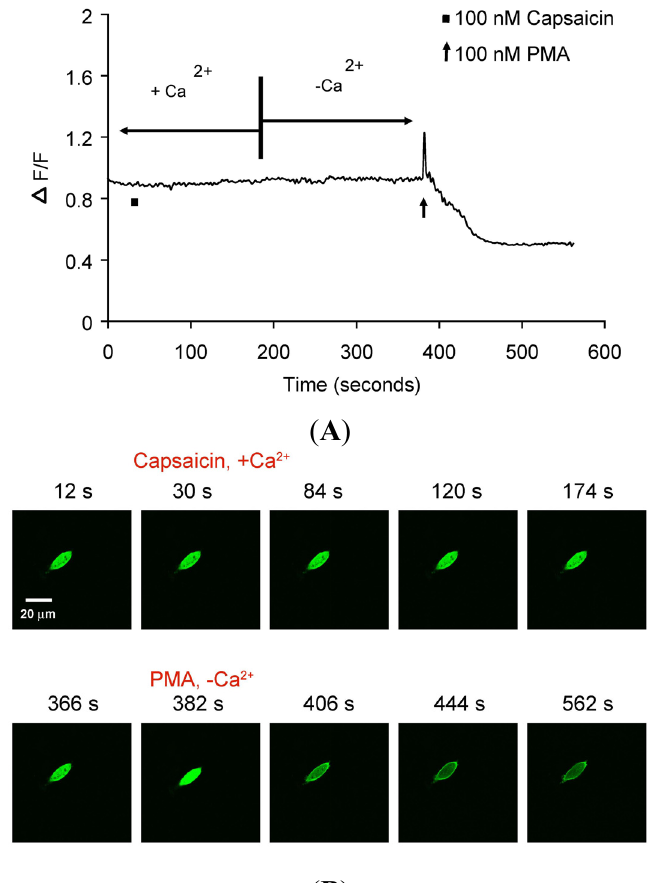
Figure 4. Translocation kinetics of PKC β II-EGFP in a single cell body of CHO cell from a culture transfected with PKC β II-EGFP